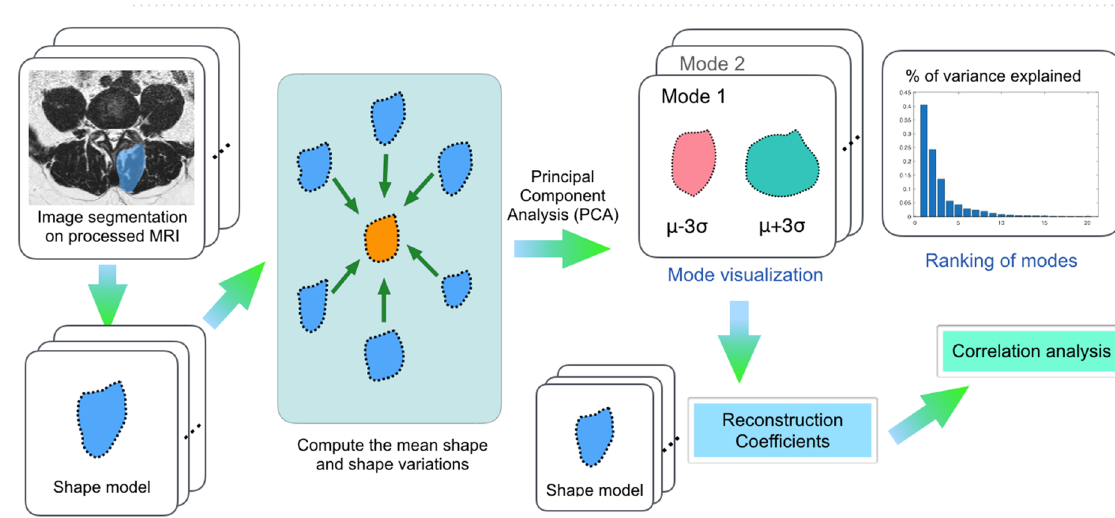
Figure 2. Demonstration of statistical shape analysis for paraspinal